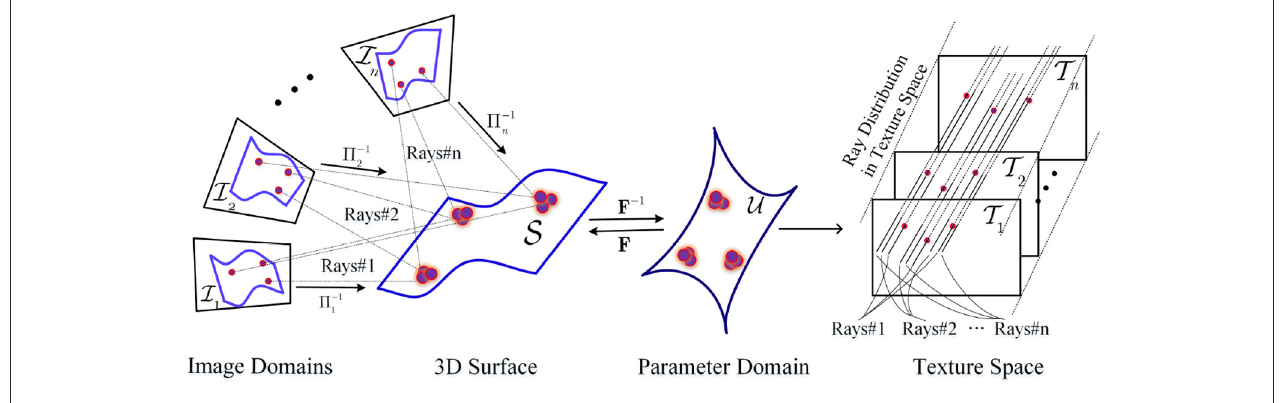
FIGURE 2 | Geometric optics of multiple BP